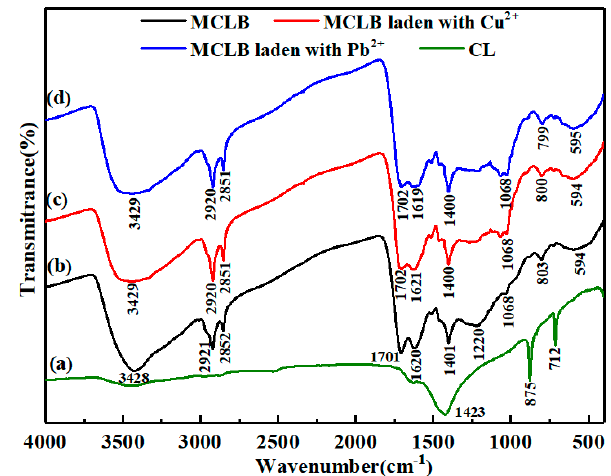
Figure 4. Fourier transform infrared spectra(FTIR) of CL ( a ) and CLB ( b ) before and after 0.3 mM Cu(II) ( c ) and 0.3 mM Pb(II) ( d ) adsorption, respectively.